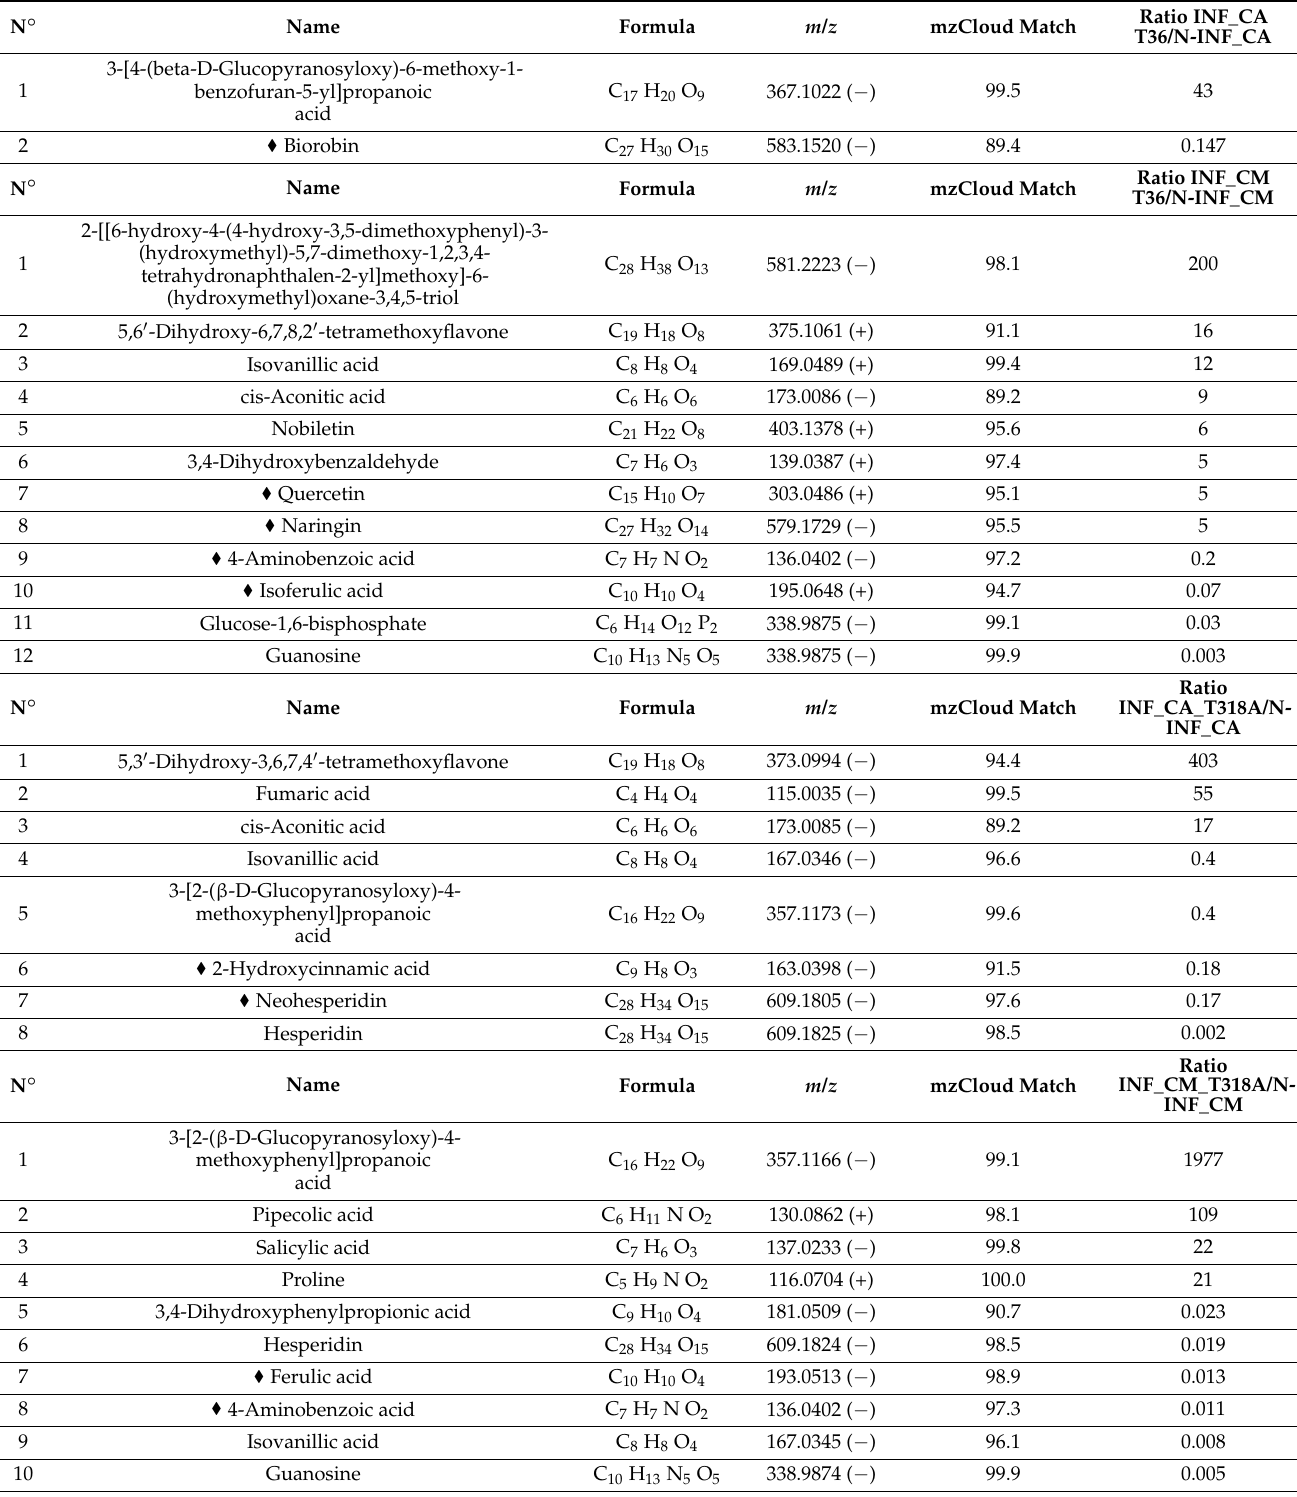
Table 2. Metabolites tentatively annotated in the phloem sap of infected and non-infected Citrus aurantium (CA) and C. macrophylla (CM). The ratios of annotated compounds are listed in descending order. Listed compounds have a mzCloud match ≥ 85% (negative or positive polarity) and a p -value < 0.01. Compounds labelled with the symbol (cid:7) were also annotated in Table